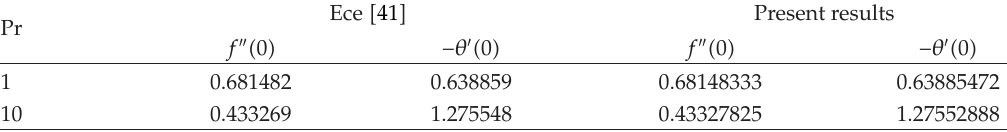
Table 1: Comparison of SLM results for single component convection (cid:3) λ (cid:10) 0 and D f (cid:10) Sr (cid:10) 0 (cid:4) with Ece (cid:6) 41 (cid:7) . Pr